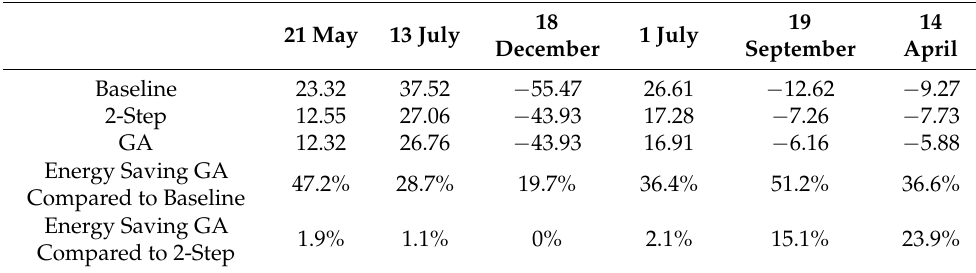
Table 10. HVAC loads for baseline windows and optimized STIS–smart windows applied to a house located in Chicago, IL for six representative days using two control strategies (negative sign indicates heating loads).